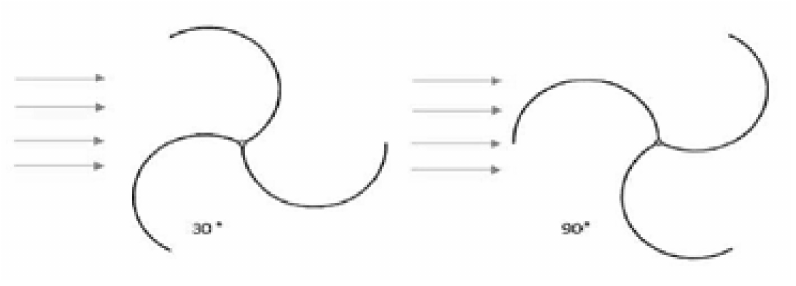
Figure 18. The Ice Wind rotor best fit the configuration for CFD analysis [87,88].